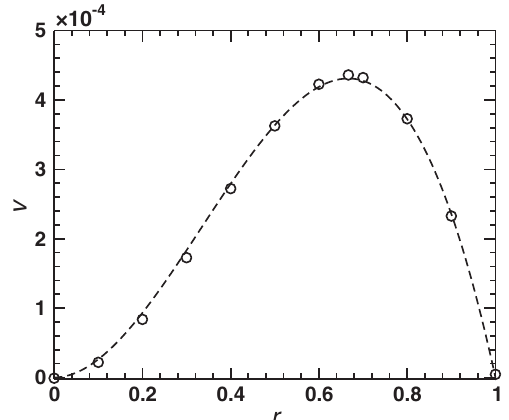
FIG. 3. Ratchet effect induced in a damped sine-Gordon sys- tem [cf. Eq. (19)] driven by the force (16) upon changing the amplitudes a ¼ r(cid:2) and b ¼ ð 1 (cid:1) r Þ (cid:2) . The velocity v is plotted ¼ (cid:4)= 2 , (cid:10) ¼ as a function of r . Parameters are ! ¼ 0 : 05 , (cid:3) 1 ¼ 0 : 644 86 is chosen so that v 0 : 05 , and (cid:2) ¼ 0 : 03 . Phase (cid:3) 2 vanishes for r ¼ 0 . Circles are results obtained from the simu- lations. The line is the fitted curve v ¼ 0 : 002 908 9 ð 1 (cid:1) r Þ r 2